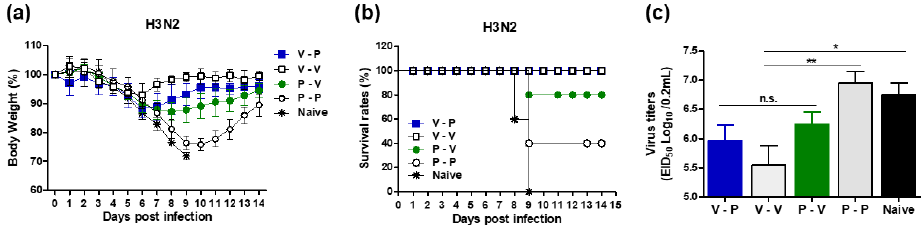
Figure 2. The 5xM2e VLP primed mice display enhanced protection against H3N2 virus. Immunized mice ( n = 10 per group) were infected with a lethal dose of A/Philippine/2/1982 (H3N2) at 11 weeks after boost immunization. Lung viral titers were detected by inoculating chicken eggs. EID 50 , 50% egg infections dose. ( a ) Body weight changes. ( b ) Survival rates. ( c ) Lung viral titers. Naïve: naïve mice infected with influenza virus, V-P: VLP prime/protein boost, P-V: protein prime/VLP boost, P-P: protein prime boost, V-V: VLP prime boost. The statistical significance was confirmed by one-way ANOVA and Dunnett’s multiple comparison test. Error bars indicate the means ± SEM of concentration from individual animals. *; p < 0.05, **; p < 0.01. n.s.; no